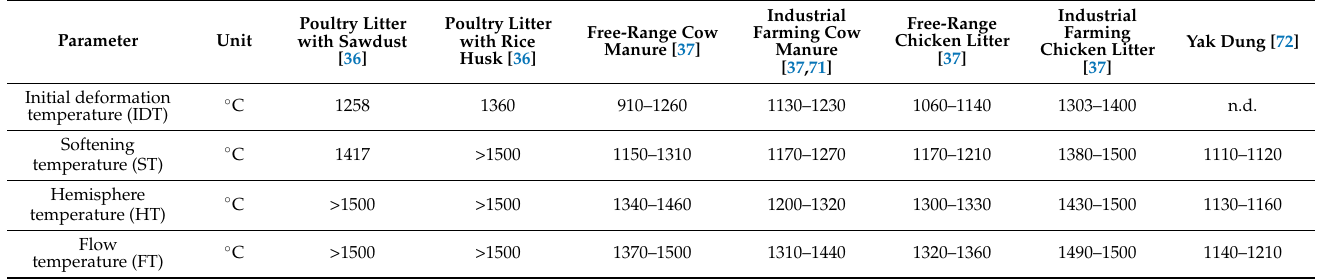
Table 4. Ash fusion temperatures (AFTs) of animal-origin biomass (n.d.—no